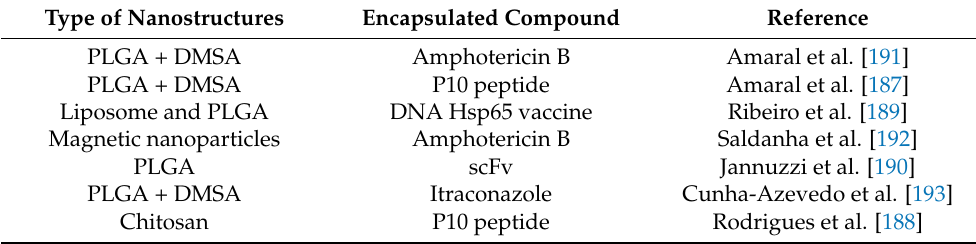
Table 1. Different strategies using nanotechnology for the treatment of experimental PCM. Type of Nanostructures Encapsulated Compound Reference PLGA + DMSA Amphotericin B Amaral et al. [191] PLGA + DMSA P10 peptide Amaral et al. [187] Liposome and PLGA DNA Hsp65 vaccine Ribeiro et al. [189] Magnetic nanoparticles Amphotericin B Saldanha et al. [192] PLGA scFv Jannuzzi et al. [190] PLGA + DMSA Itraconazole Cunha-Azevedo et al. [193] Chitosan P10 peptide Rodrigues et al.